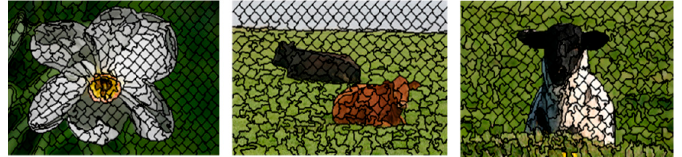
Figure 3. A few examples of super pixel-based pre-segmentation.